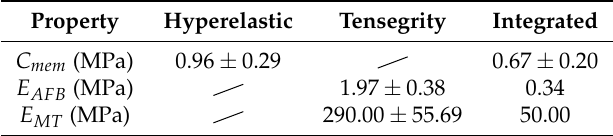
Table 5. Material properties estimated in different modelling